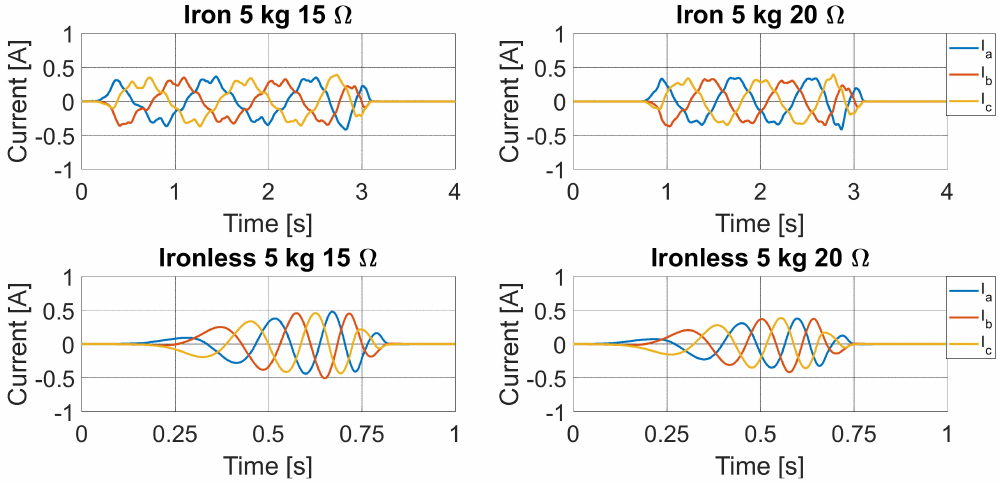
Figure 14. Load currents trends of the 5 kg test with a resistance load equal to 15 Ω and 20 Ω .